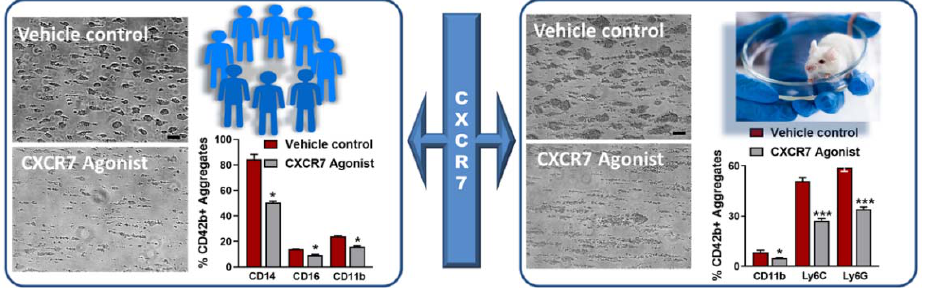
Figure 2. CXCR7-agonist reduces thrombotic response and thrombo-inflammatory platelet interaction with leukocytes ex vivo. Blood from healthy human subjects or mice pre-treated with vehicle control (1% DMSO) or CXCR7-agonist (100 µ g/mL) for 30 min at room temperature is perfused through a transparent flow chamber (slit depth 50 µ m) over a collagen (100 µ g/mL)-coated surface at 1700 s − 1 (human) or 1000 s − 1 (murine) wall shear rate. After blood perfusion, the chamber is rinsed with PBS and images are captured from randomly chosen microscopic areas (Axiovert 200, Carl Zeiss, optical objective 20x). Phase contrast images for relative thrombus coverage shows a decreased thrombus formation in CXCR7 ‐ agonist ‐ treated human and murine blood. Bar = 20 μ m. Effluent blood from the flow chamber is collected and analyzed for platelet ‐ leukocyte aggregate formation by flow cytometry using platelet (CD42b) and leukocyte population specific surface markers (CD14, CD16, Ly6G, Ly6C). Bar diagram shows platelet ‐ leukocyte aggregate formation is significantly reduced in the presence of CXCR7 ‐ agonist as compared to vehicle control. Data are mean ± S.E.M from 5 independent experiments performed with blood n = 5 healthy subjects and n = 5 C57BL/6J mice. * p < 0.05, *** p < 0.001 with Mann–Whitney U ‐ test.